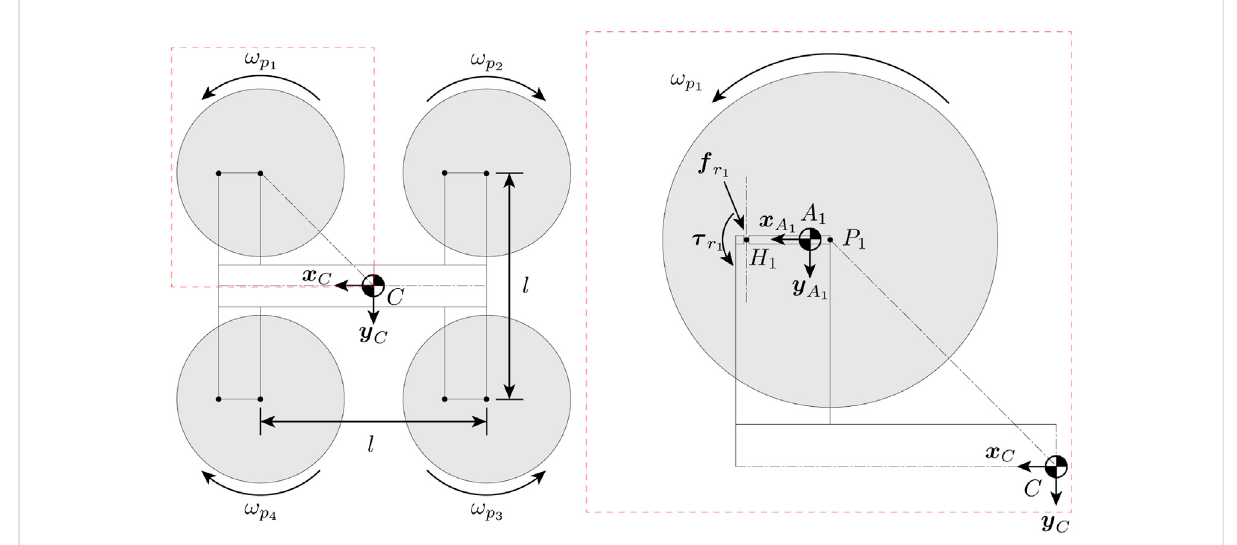
FIGURE 3 Top-down view of the vehicle model in the untilted con fi guration. The propellers are numbered 1, 2, 3, 4 in a clockwise manner. The right side shows the detailed view of rotor 1, where P 1 is thelocation ofthe rotor, A 1 is theCOM of the armthat therotor is attachedto, and H 1 is thehinge that the arm can tilt about. Reaction force f r and torque τ r act in opposite directions between each arm and the central body at the hinge H 1 1 1